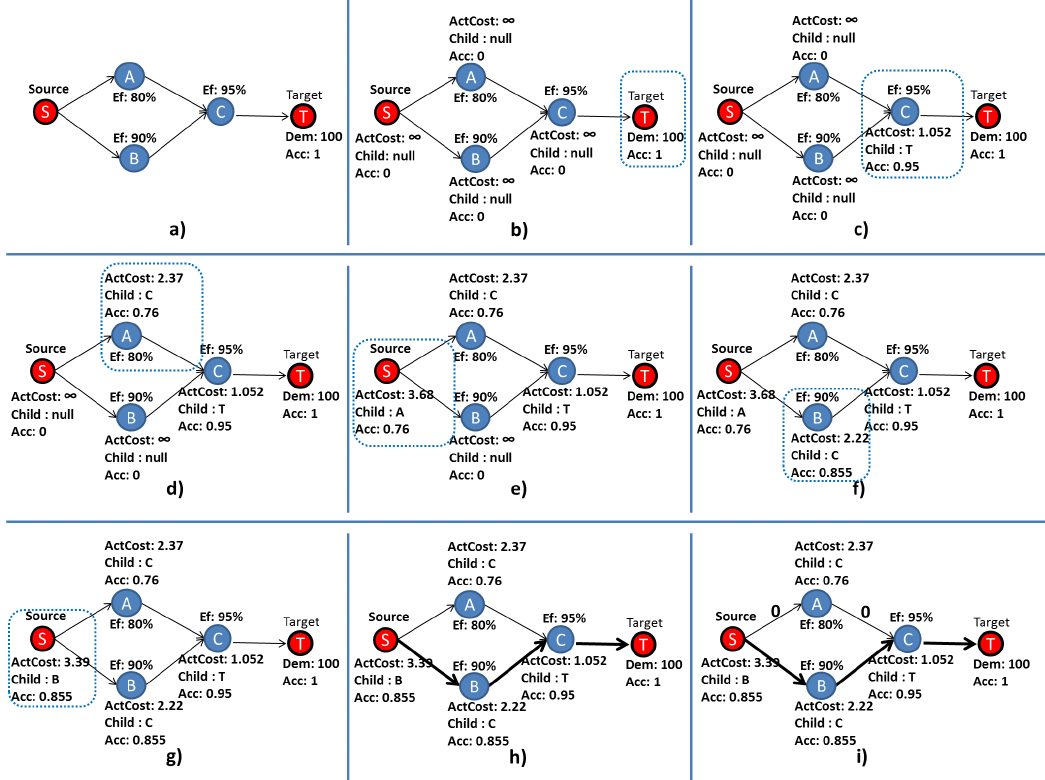
Figure 11. Example PLDA-D execution; blue rectangles highlight the nodes under